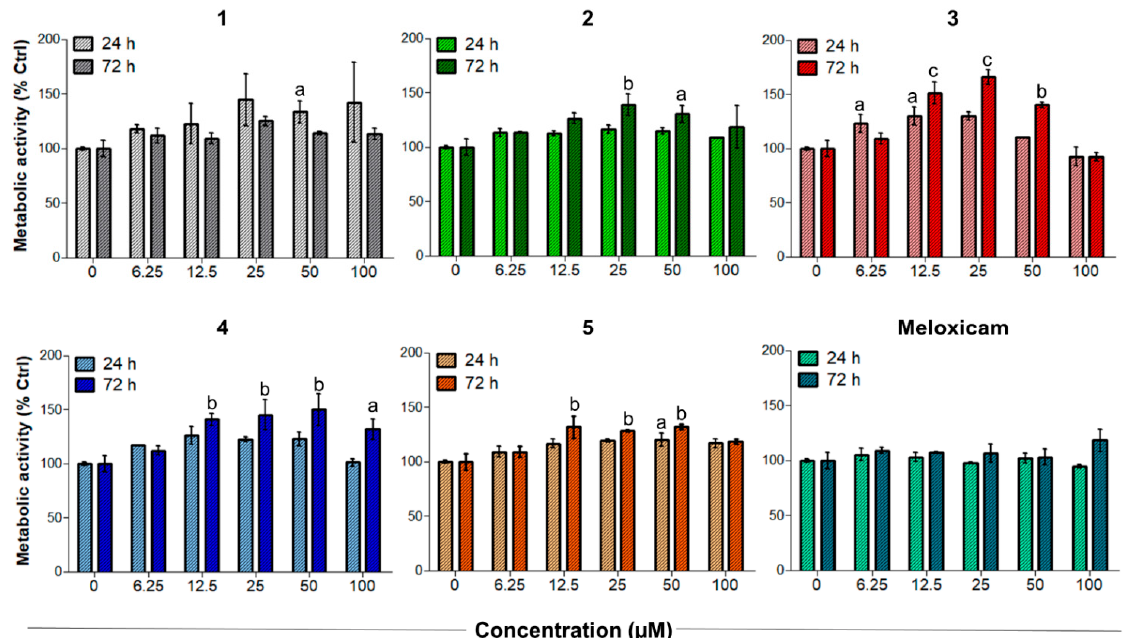
Figure 5. Metabolic activity of H 2 O 2 -pre-incubated human primary tendon-derived cells exposed to increasing concentrations of CORMs (compounds 1 – 5 ) after 24 and 72 h. Cells were pre-incubated with H 2 O 2 100 µ M for 3 h. The control sample (0 μ M = cells pre-incubated with H 2 O 2 and treated with DMSO 0.1%) is set as 100%. a = p < 0.01; b = p < 0.001; c = p < 0.0001 between cells treated with CORMs and the control sample.